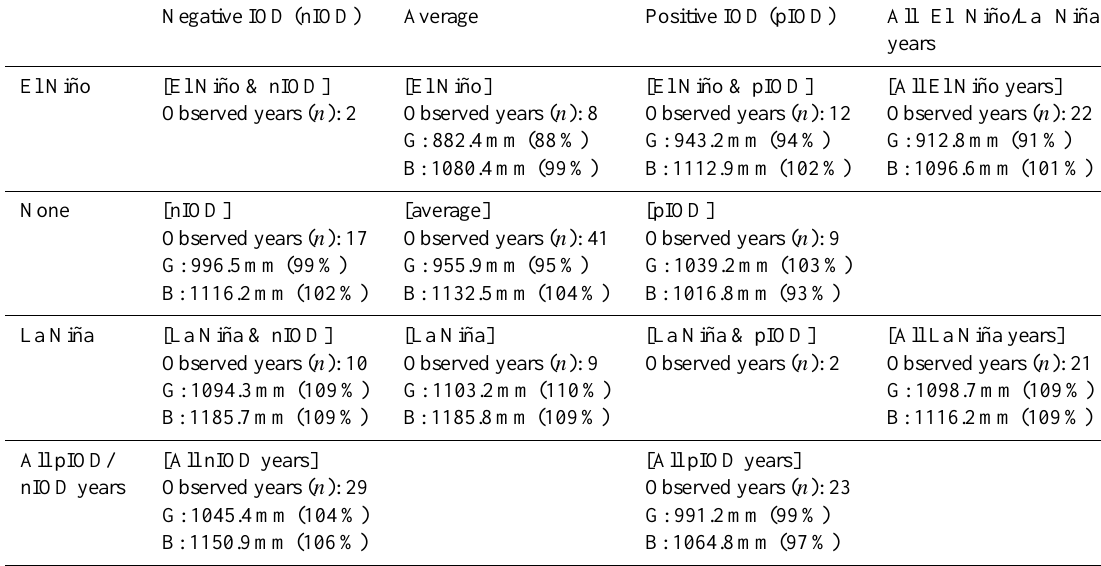
Table 1. Composite of the June–October total precipitation (mm) when El Niño, La Niña, and positive and negative IOD events occurred, co-occurred, or did not develop along with the observed number of years ( n ) in each category indicated. The observed years for each category are provided in Appendix A. The basin precipitation was not computed for the co-occurrences of El Niño and negative IOD events, and of La Niña and positive IOD events because of the small number of observed years for these categories. Negative IOD (nIOD) Average Positive IOD (pIOD) All El Niño/La